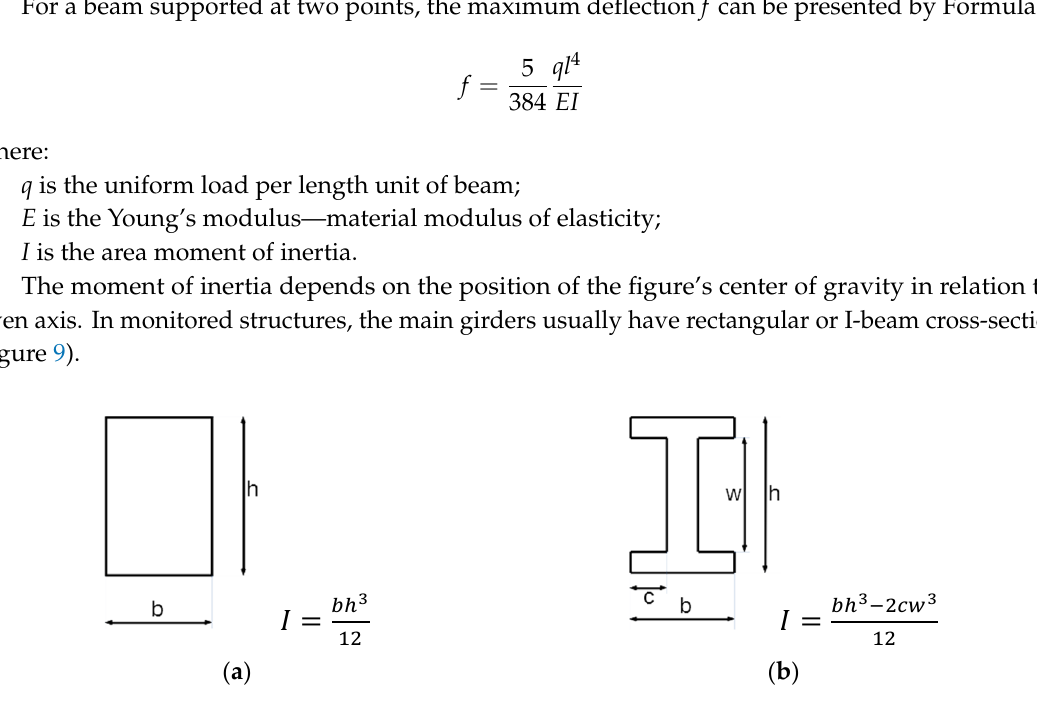
Figure 9. Cross section of typical beams and their area moment of inertia (I), ( a ) rectangular beam, ( b ) I-beam.